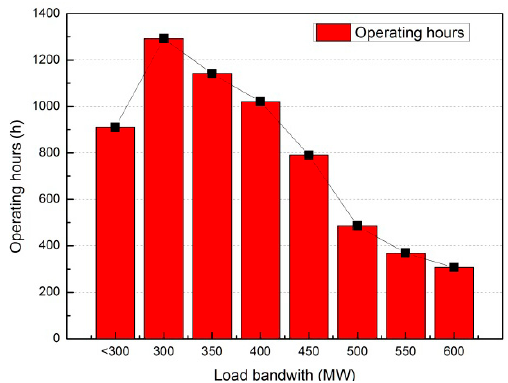
Figure 2. Operating hours by load bandwidth.